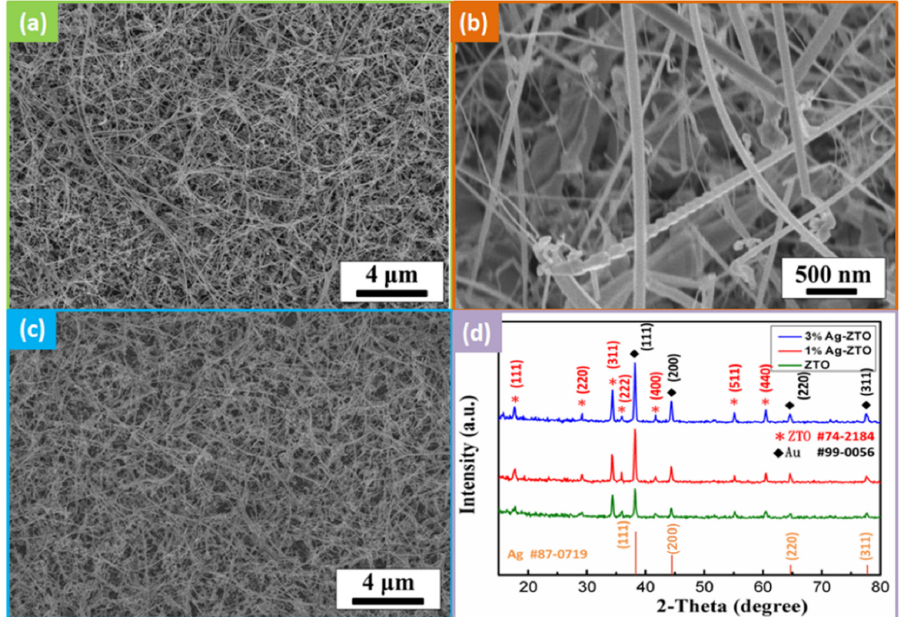
Figure 1. Morphologies of ZTO NWs and Ag-ZTO NWs. ( a ) Low magnification SEM image of ZTO NWs. ( b ) High magnification SEM image of ZTO NWs. ( c ) Low magnification SEM image of Ag-ZTO NWs. ( d ) XRD pattern of ZTO NWs and Ag-ZTO NWs.